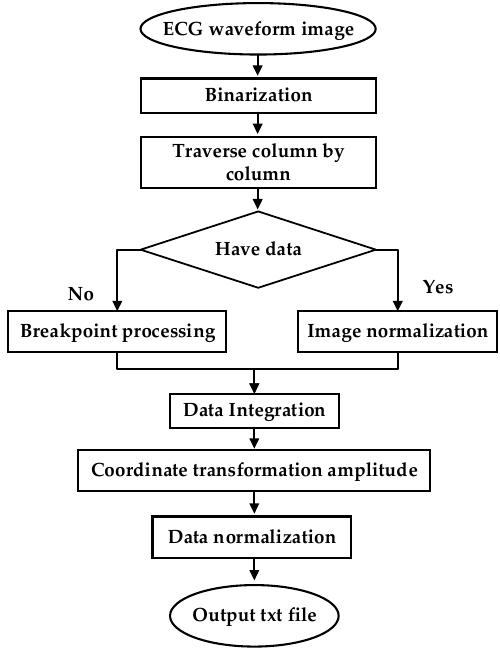
Figure 8. ECG waveform image to data.